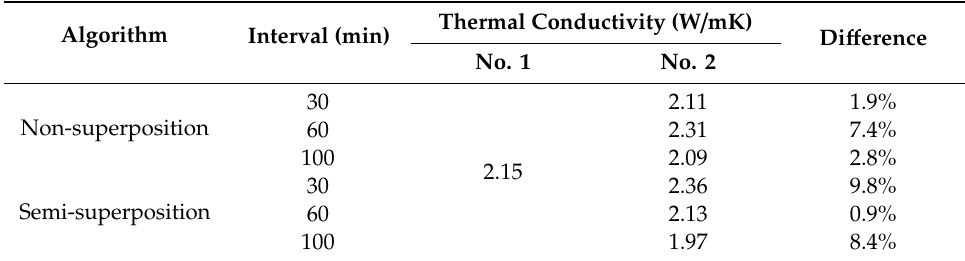
Figure 9. The e ff ective thermal conductivity of the ground estimated by deploying the Figure 9. The effective thermal conductivity of the ground estimated by deploying the semi- superposition method. ( a ) 30 min, ( b ) 60 min, ( c ) 100 min. Table 4. Comparing the e ff ective thermal conductivity of the ground for a treated TRT with interrupted power input at a “stable” period with that of a TRT with stable power